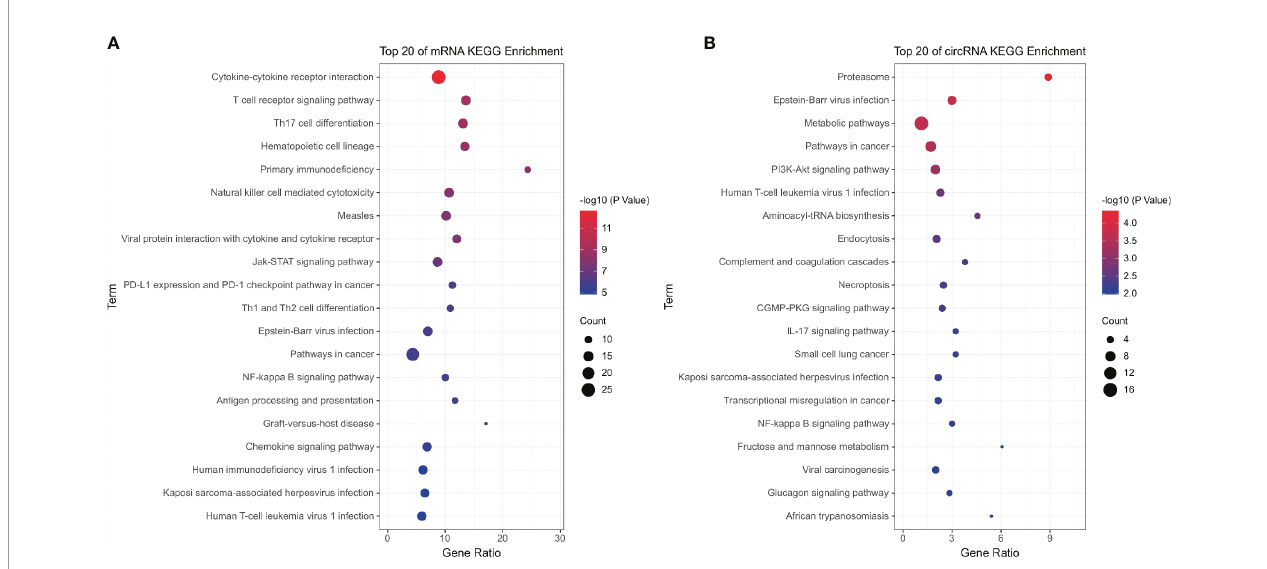
FIGURE 2 | KEGG pathway analysis of the differentially expressed mRNAs and circRNAs. (A) Differentially expressed mRNAs; (B) differentially expressed